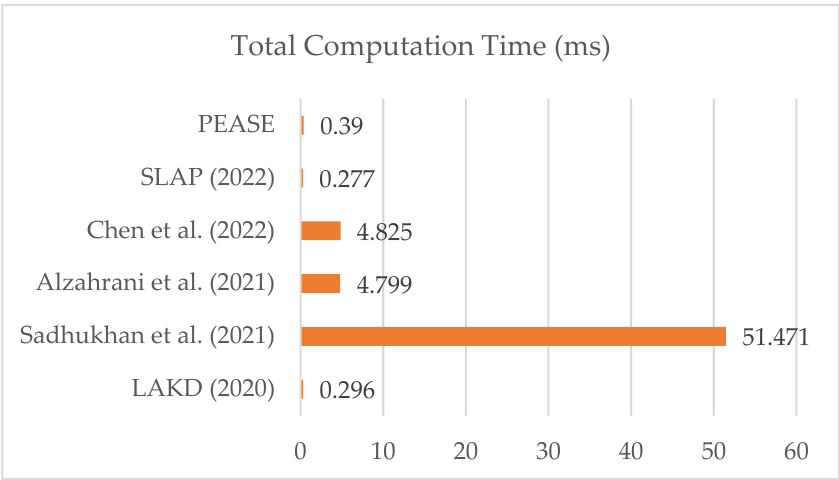
Figure 9. Performance comparison based on execution time.